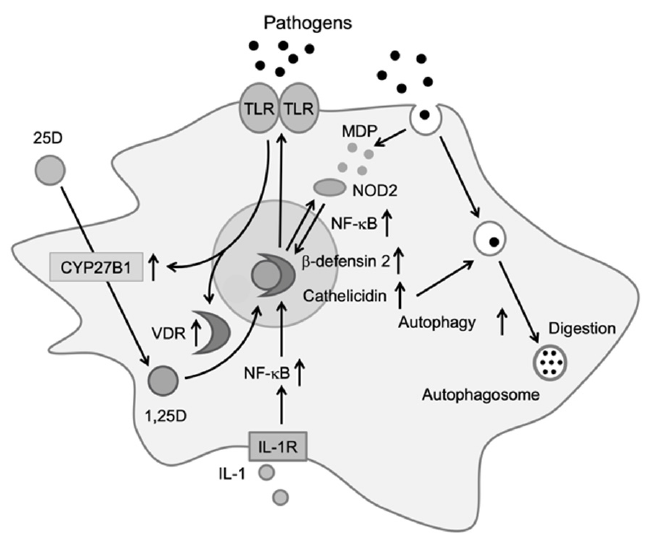
Figure 1. Effects of vitamin D on immune cells. Activation of toll-like receptors by pathogens increases the expression of vitamin D receptor (VDR) and CYP27B1. Upon entering the cell, 25D is metabolized to 1,25D by CYP27B1. 1,25D then binds to VDR, which induces cathelicidin and β -defensin 2. Cathelicidin promotes antibiotic activity via autophagy [14] .